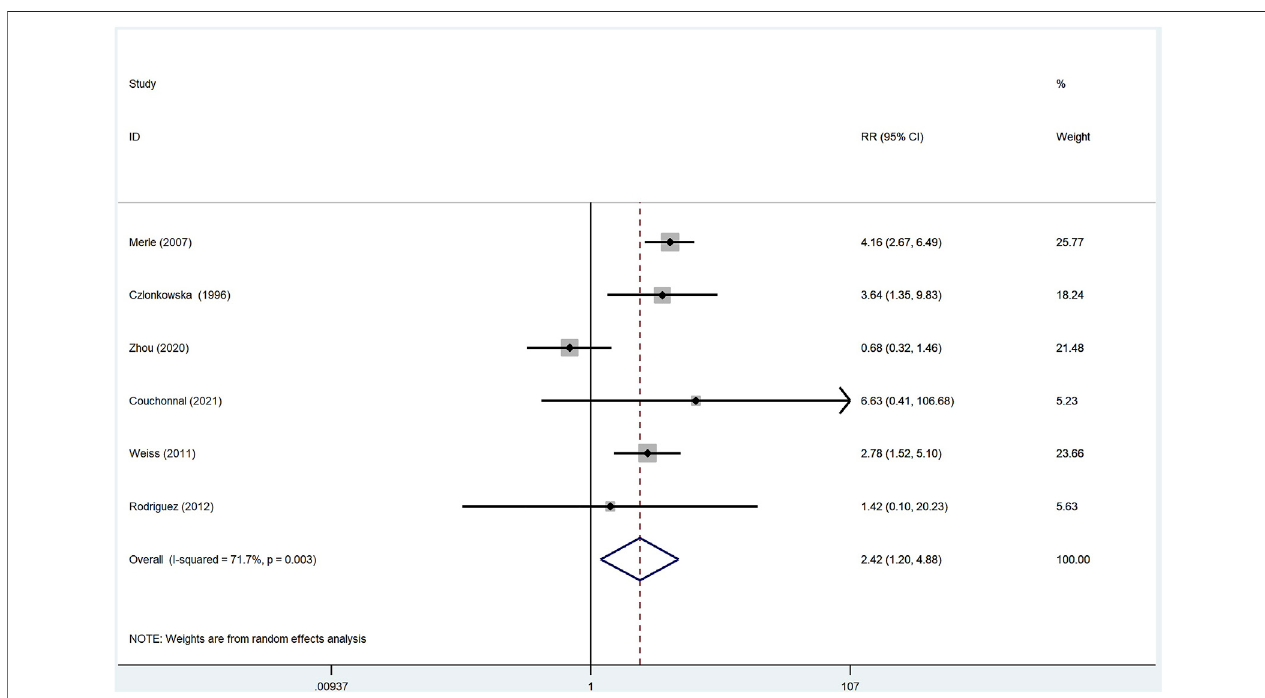
FIGURE 4 | Meta-analysis of adverse effects in WD patients treated with D -penicillamine compared with zinc salts.